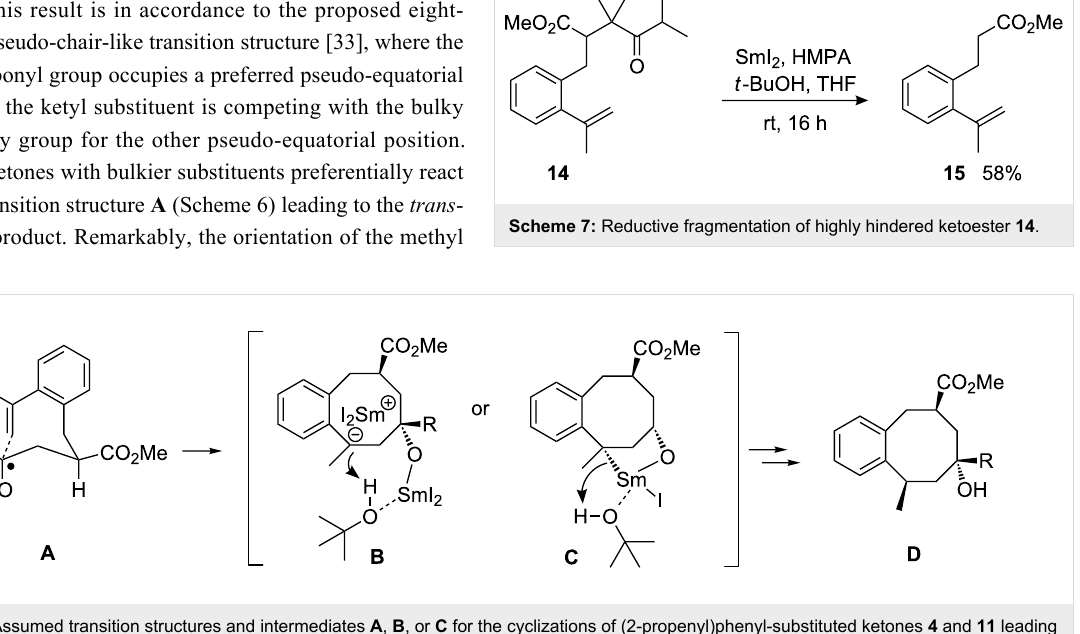
Scheme 6: Assumed transition structures and intermediates A , B , or C for the cyclizations of (2-propenyl)phenyl-substituted ketones 4 and 11 leading to products of type D (HMPA ligands at the samarium are omitted for simplicity).